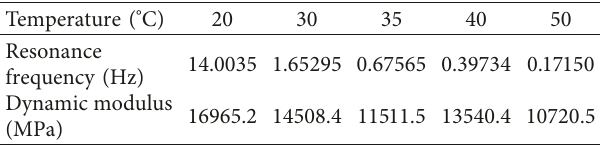
Table 3: Dynamic modulus and resonance frequencies of